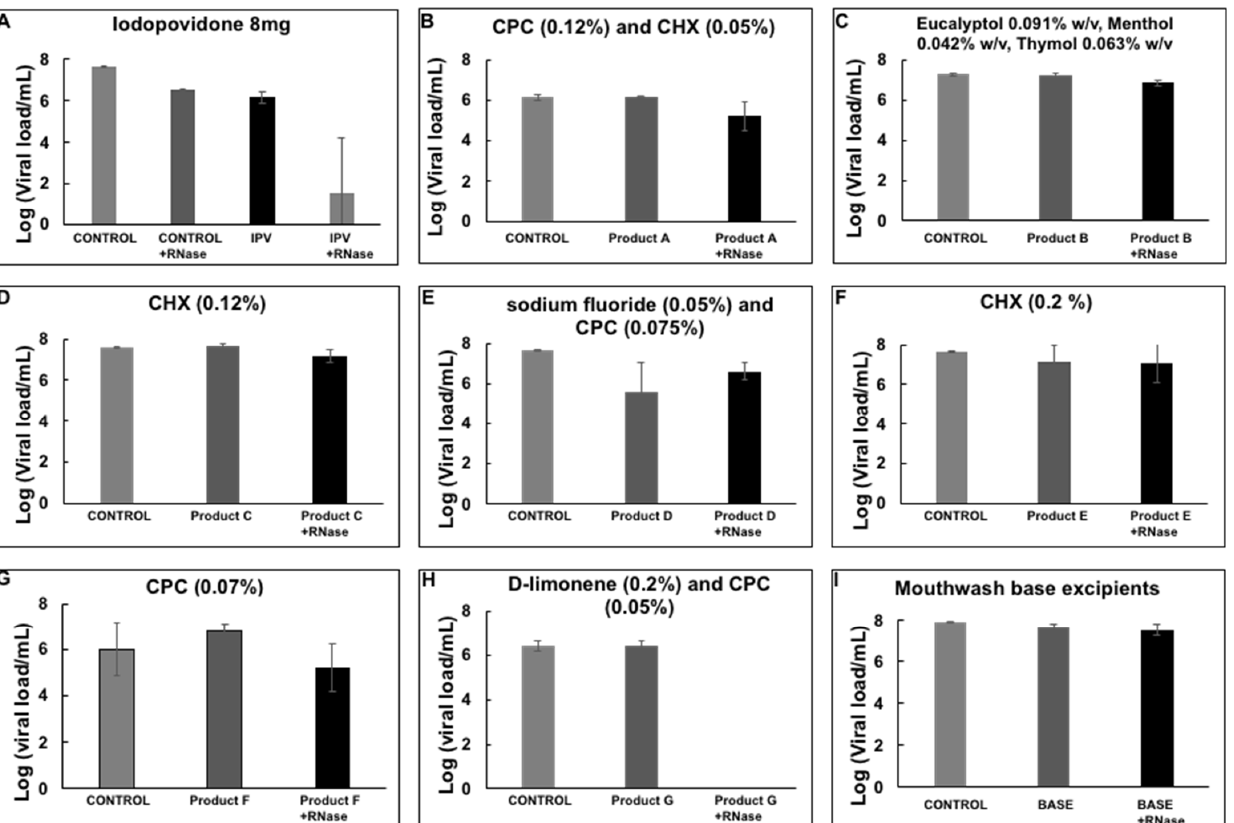
Figure 3. Viral load reduction of SARS-CoV-2 from nasopharyngeal samples by mouthwash prod- ucts. ( A ) Iodopovidone *; ( B ) Product A **; ( C ) Product B †† ; ( D ) Product C ††† ; ( E ) Product D *** ; ( F